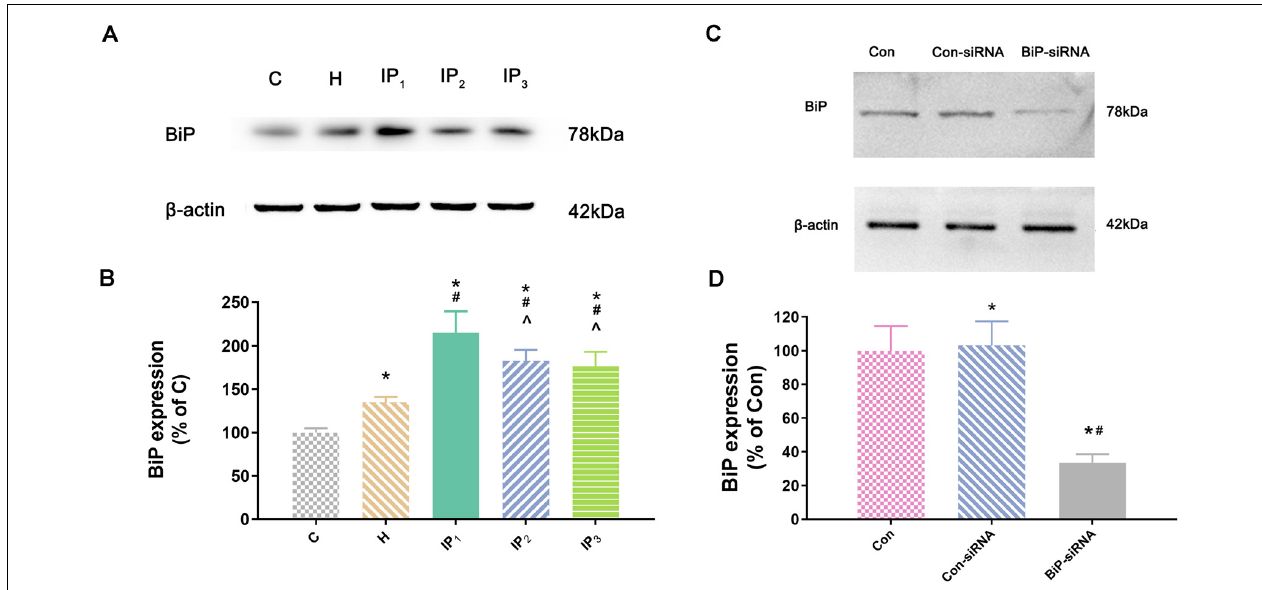
FIGURE 2 | The expression of BiP in hippocampal neurons. (A) The expression of BiP in hippocampal neurons was determined by Western blotting. (B) Statistical graph of the expression of BiP. Note that treatment with isoflurane and propofol caused distinctly increase in BiP expression of hypoxic neurons. Data are expressed as the mean ± SD ( n = 6/group). (C) Verifying siRNA targeting BiP on BiP protein expression. BiP-siRNA significantly down-regulates BiP protein expression. (D) Statistical graph of the expression of BiP. Data are expressed as the mean ± SD ( n = 6/group). * P < 0.05 compared with group Con; # P < 0.05 compared with group Con-siRNA; ∧ P < 0.05 compared with group IP 1